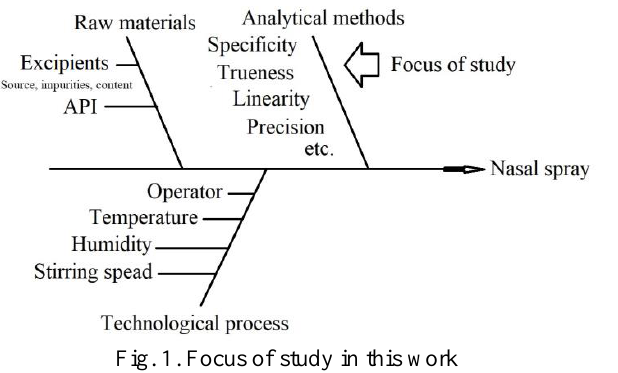
Fig. 1. Focus of study in this